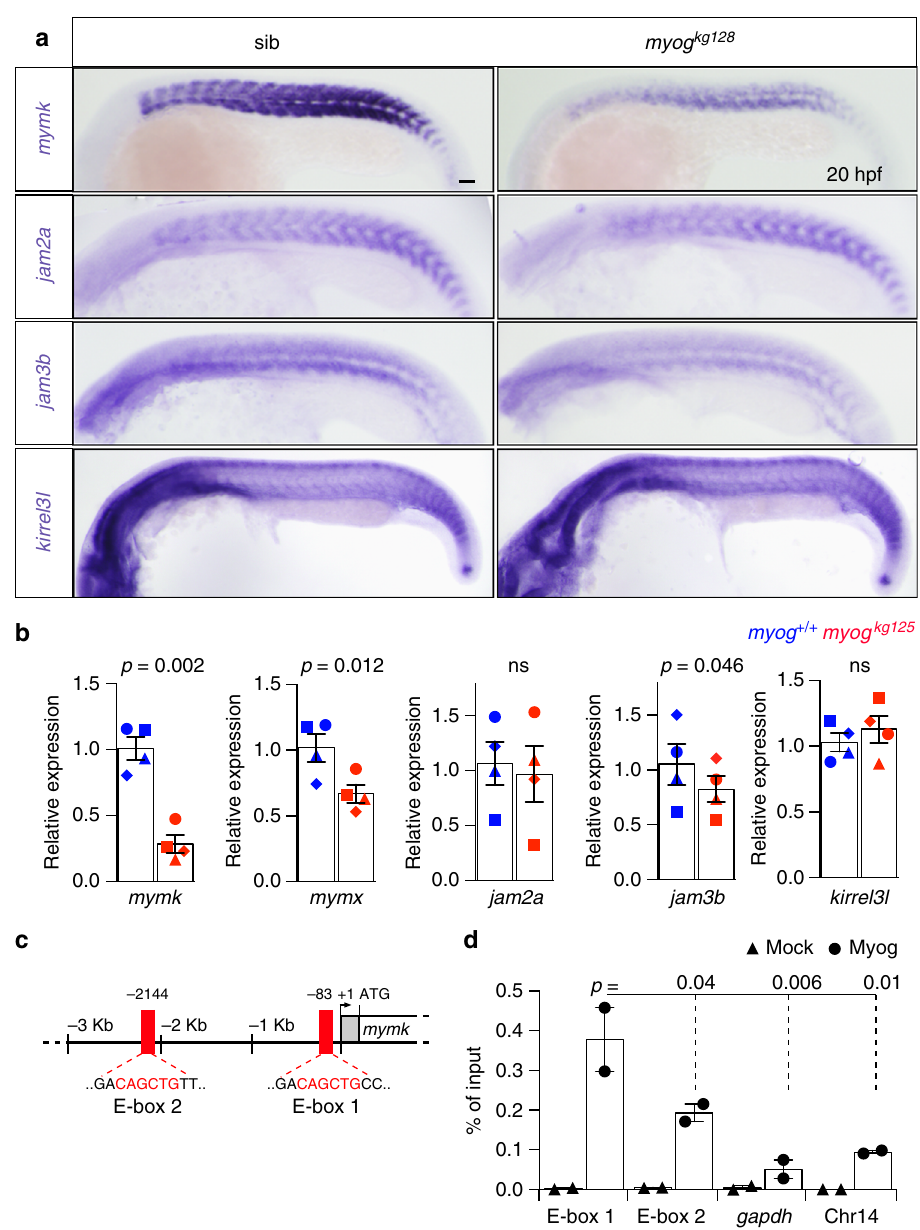
Fig. 5 Myogenin mutants have reduced expression of fusogenic factors. a ISH on 20 hpf myog kg128/ + incross to investigate the expression of genes essential for vertebrate myocyte fusion. Expression of myomaker ( mymk ) and jam3b , but not of jam2a or kirrel3l , is reduced in myog mutant. Bar = 50 μ m. Representative images n = 10 mutants, n = 38 sibs ( mymk ); n = 13 mutants, n = 37 sibs ( jam2a ); n = 12 mutants, n = 39 sibs ( jam3b ); n = 7 mutants, n = 13 sibs ( kirrel3l ). b qPCR analysis of RNA expression levels showing downregulation of mymk , myomixer/myomerger/minion ( mymx ) and jam3b at 20 hpf on myog kg125 mutants, whereas jam2a and kirrel3l remain unaltered compared to wt ( myog + / + ) sibs. Graphs show mean fold change ± SEM of four independent experiments; paired t test. Symbol shapes denote wt and mutant samples from paired experiments. c Schematic of 5' genomic region of mymk reporting: 5 ′ -UTR and coding sequence (grey and white boxes), position of E-box elements (red boxes), relative bp distance from 5'UTR start ( + 1), start codon (arrow, ATG). E-box 1 and E-box 2 sequences are shown in red text. d ChIP-qPCR assay using anti-Myog or mock showing signi fi cant Myogenin enrichment on mymk E-box 1 compared to negative controls from the gapdh promoter and a gene-free region on chromosome 14 containing an E-box (Chr14). Mean of percentage of input immunoprecipitated ± SD of two independent experiments,